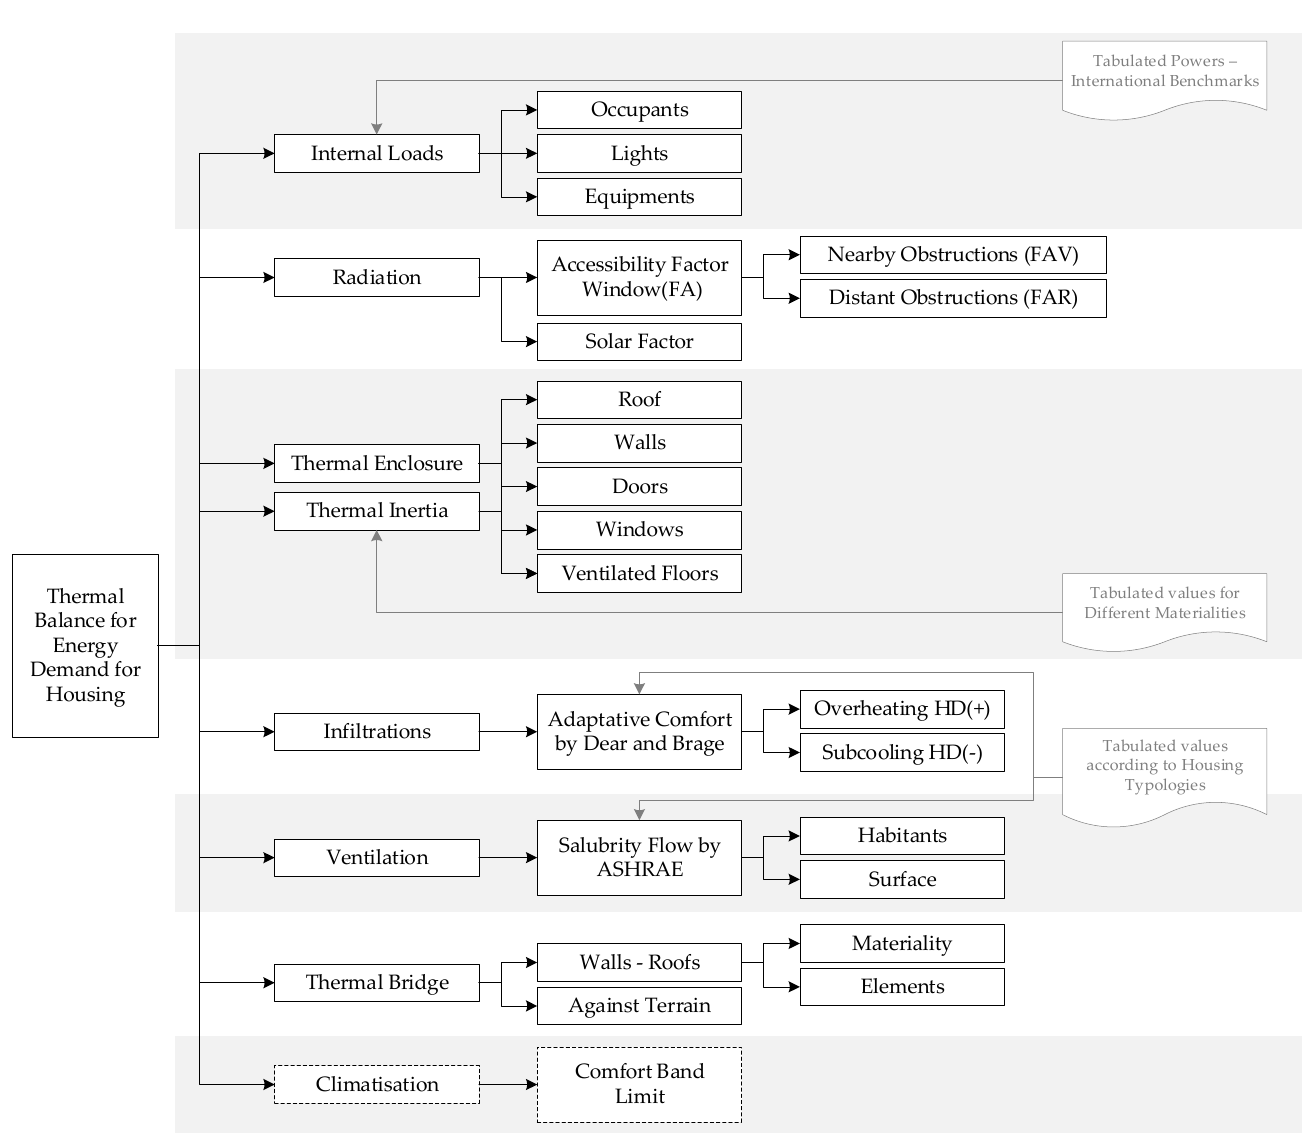
Figure 3. Internal and external factors affecting the energy demand. Figure 4 provides an overview of the factors that influence the calculation of the temperature balance. All of the factors have been grouped to identify the elements related to each factor, and to clarify which elements are involved in the calculations.